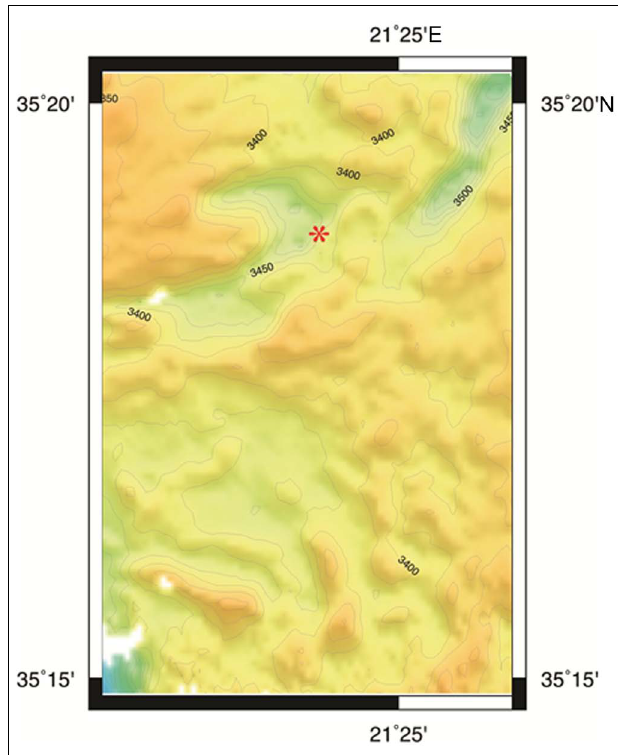
FIGURE 1 | Bathymetric map of L’Atalante DHAB generated by Seabeam. Red asterisk = approximate sample site.